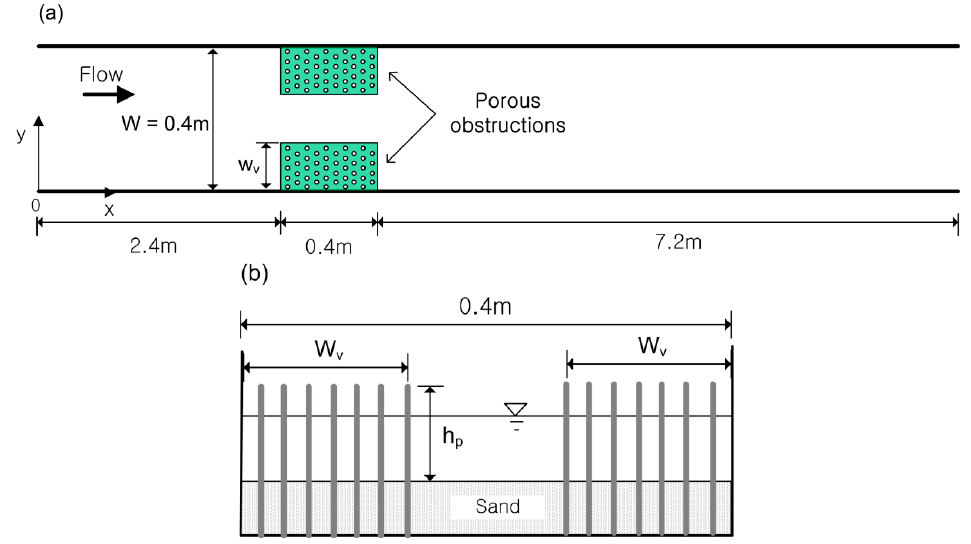
Figure 2. Experimental channel: ( a ) top view; ( b ) initial channel with porous obstructions in cross ‐ section.